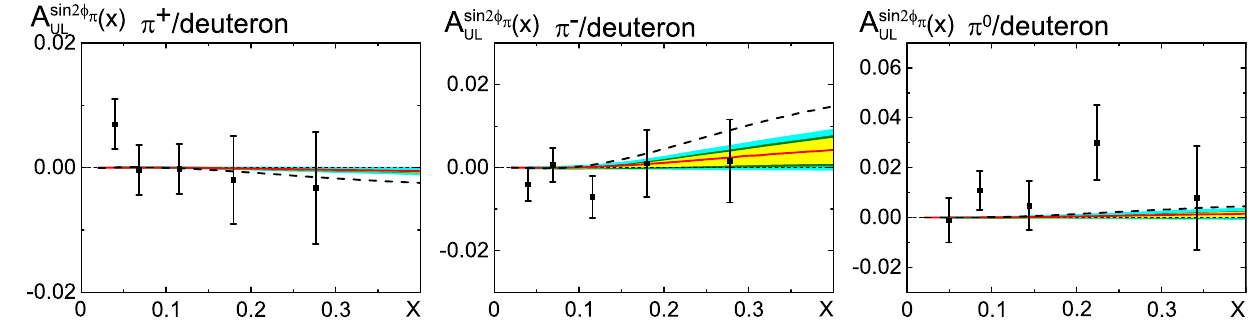
Fig. 4 Similar to Fig. 3, but for π + (left), π − (central) and π 0 (right) productions off the deuteron target. Data from Refs. [38] Fig. 5 Similar to Fig. 3, but for φ h A sin2 as function of x and UL P π T at CLAS kinematics. The upper panels of show the x dependent asymmetries for π + (left panel) and π − (right panel) production, respectively; and the lower panels depict the x − dependent (left panel) and P π T − dependent (right panel) asymmetries for π 0 production. The solid squares represent the CLAS data [39,53] for comparison. In each figure we zoom in the plots to show the tendency